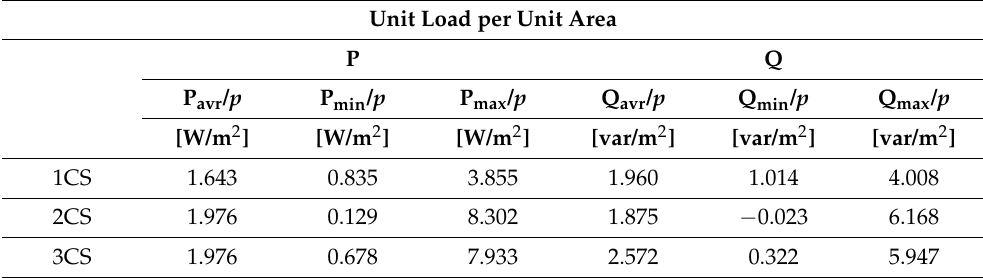
Table 7. Average, minimum, and maximum load of active and reactive power per unit area.